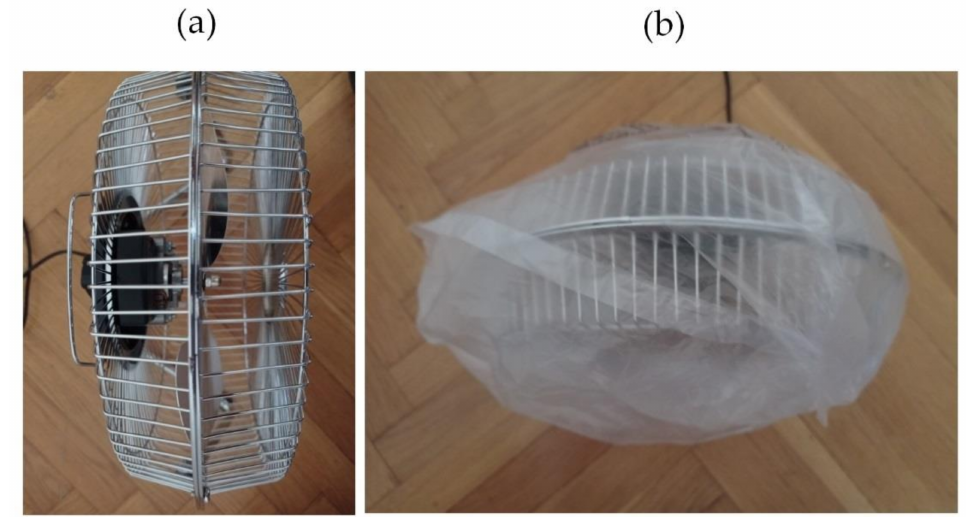
Figure 1. Analyzed fan: ( a ) healthy BLDC motor, ( b ) blocked ventilation of the BLDC